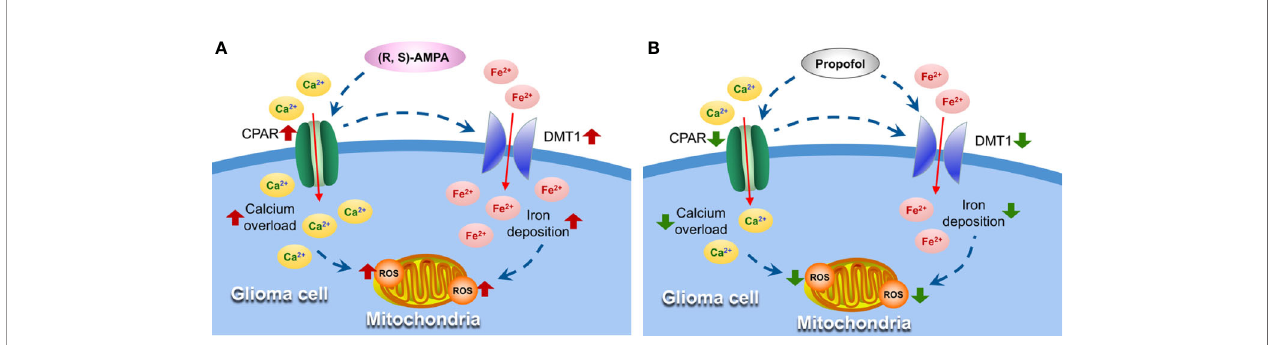
FIGURE 7 | Propofol suppresses oxidative stress in glioma cells by inhibiting DMT1 and CPAR expression. (A) AMPA receptor activator (R, S)-AMPA induces CPARs upregulation and Ca 2+ in fl ux, which can cause the excessive expression of DMT1, followed by increased ROS formation in mitochondria. (B) Propofol inhibits CPAR and DMT1 expression and eventually suppresses oxidative stress and tumor growth. DMT1, divalent metal transporter 1; AMPA, a -amino-3-hydroxyl-5- methyl-4-isoxazolepropionic acid; CPAR, Ca 2+ -permeable AMPA receptors; ROS, reactive oxygen